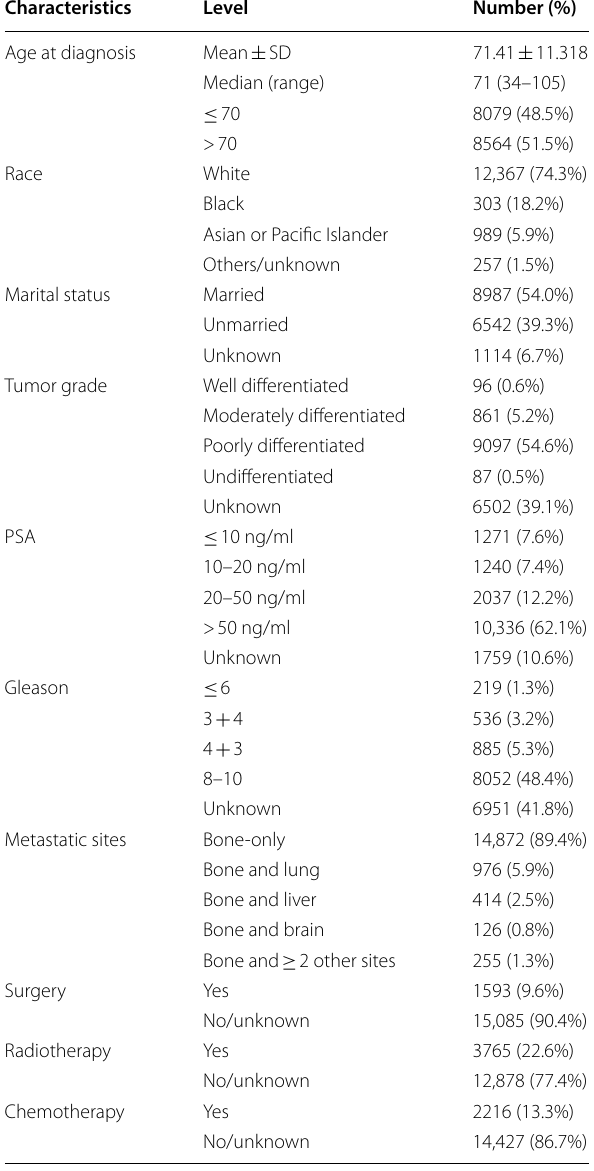
Table 1 Patient demographics and clinical